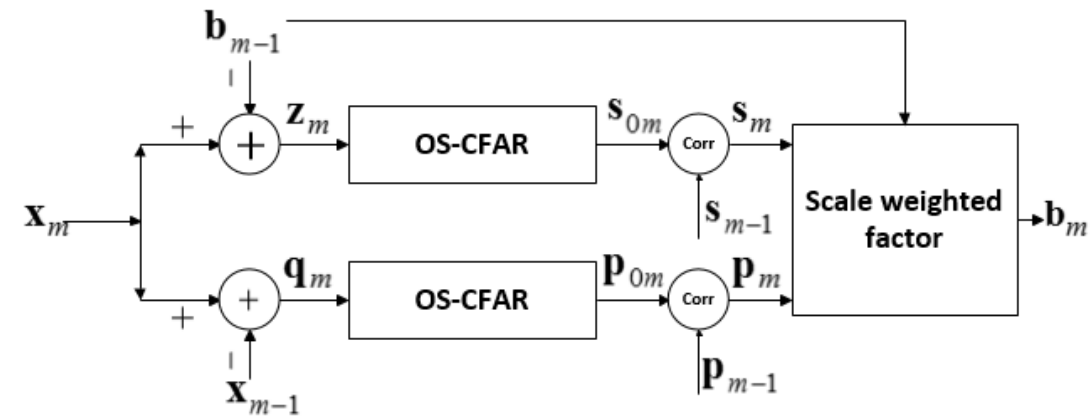
Figure 5. The flowchart of the proposed detection method based on the ordered statistics constant false alarm rate (OS-CFAR) method.